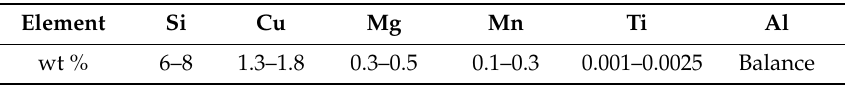
Table 1. Composition of AlSi9Cu2Mg aluminum alloy used for specimens.